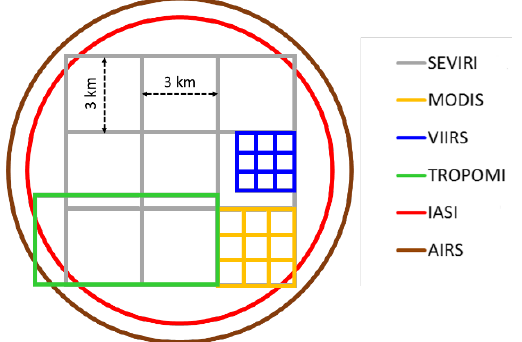
Figure 2. Nadir view ground pixel sizes for the different satellite instruments considered in the cross-comparison.